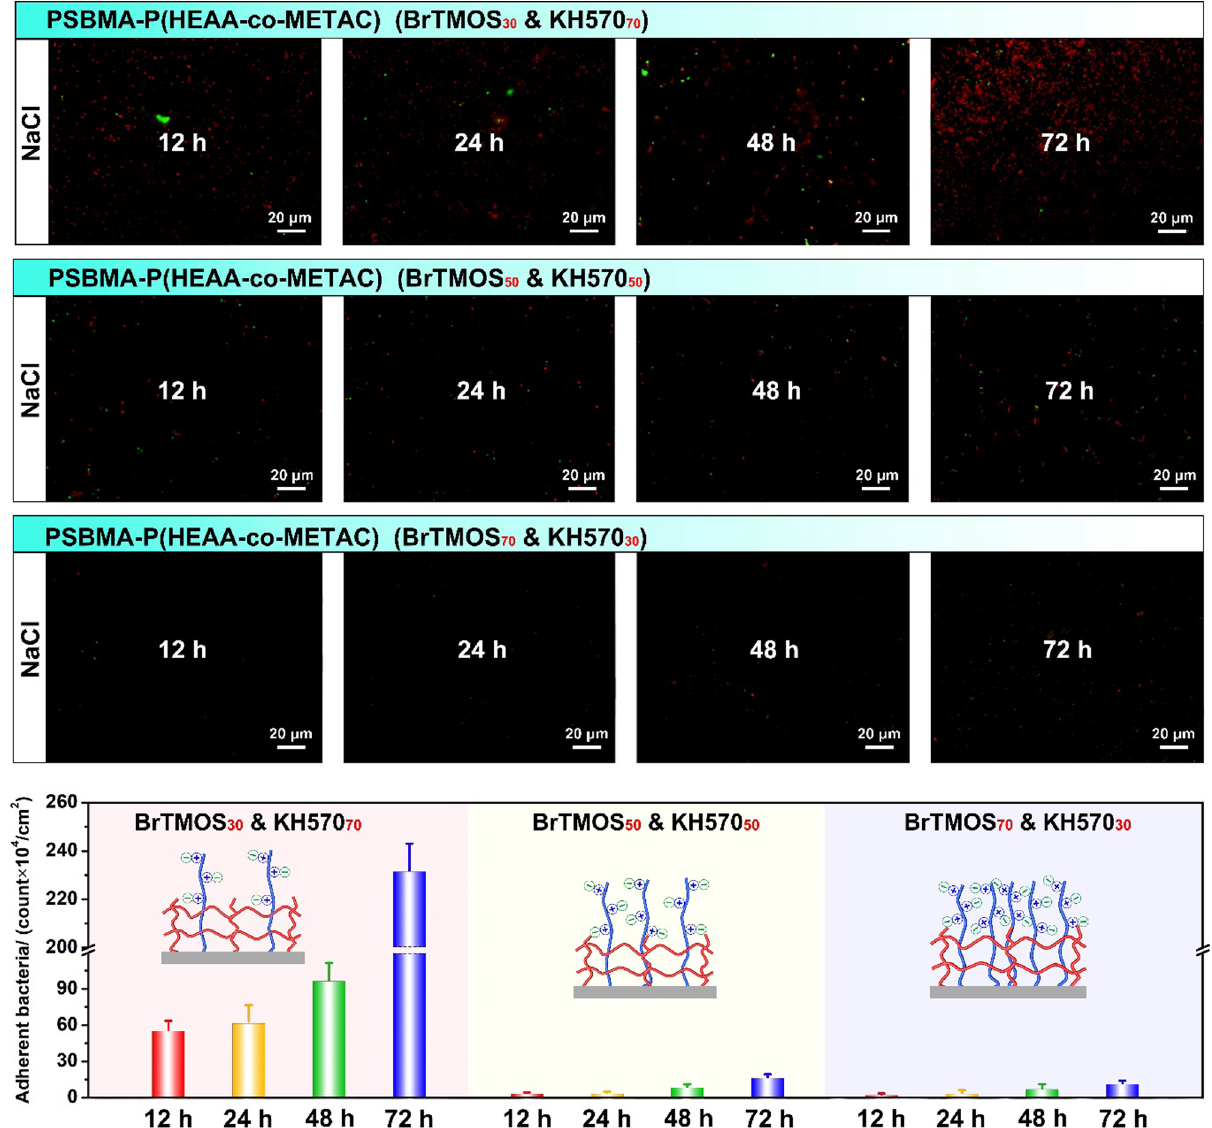
Figure 7: Florescence microscopy images of E. coli adhered on PSBMA - P ( HEAA - co - METAC ) surfaces from initial organosilanes ratios ( BrTMOS:KH570 ) of 30:70, 50:50, and 70:30 in 0.5 M NaCl